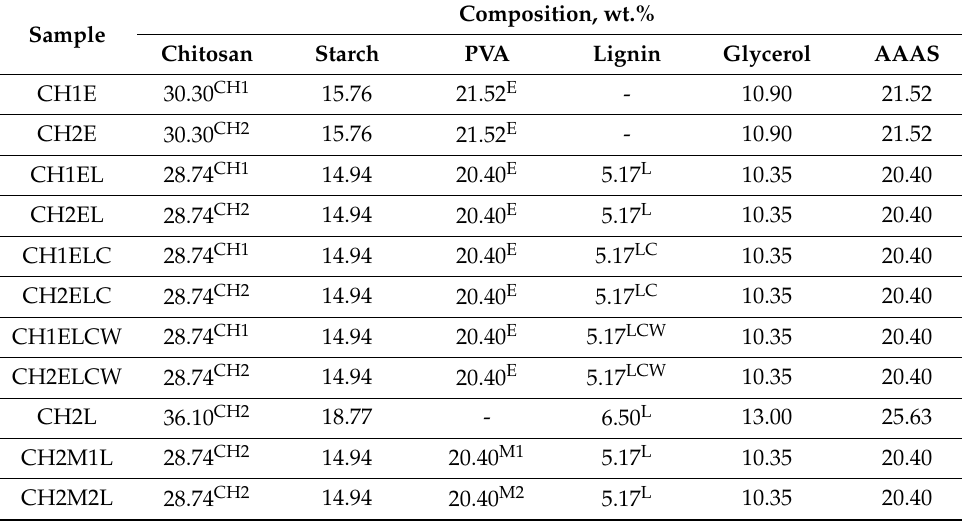
Table 1. Composition of chitosan/starch-based